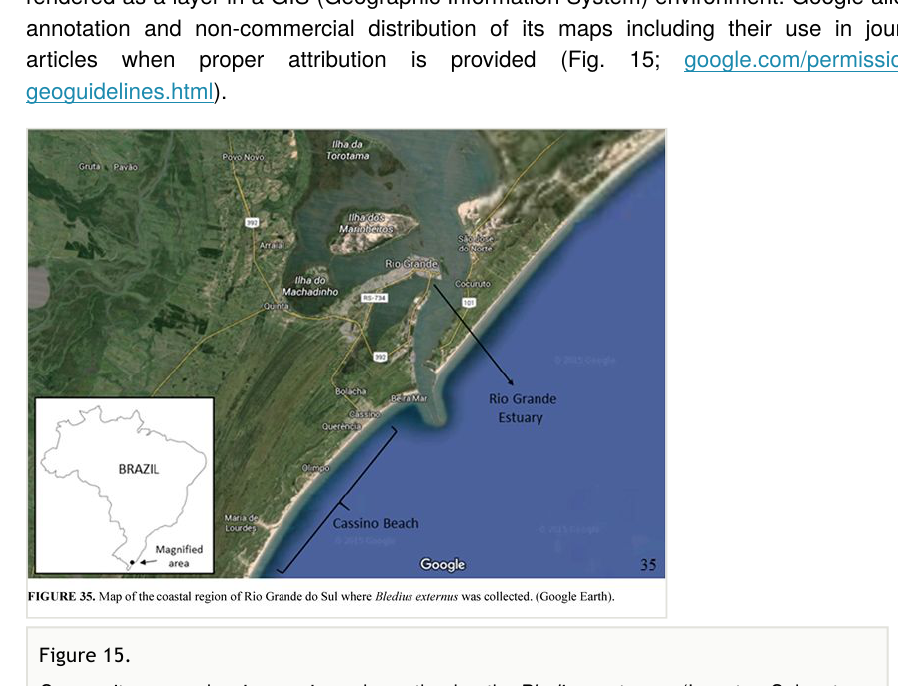
Composite map showing region where the beetle Bledius externus (Insecta: Coleoptera: Staphylinidae: Oxytelinae) was collected. This map incorporates elements obtained from Google Earth attributed to their source. From Castro et al.